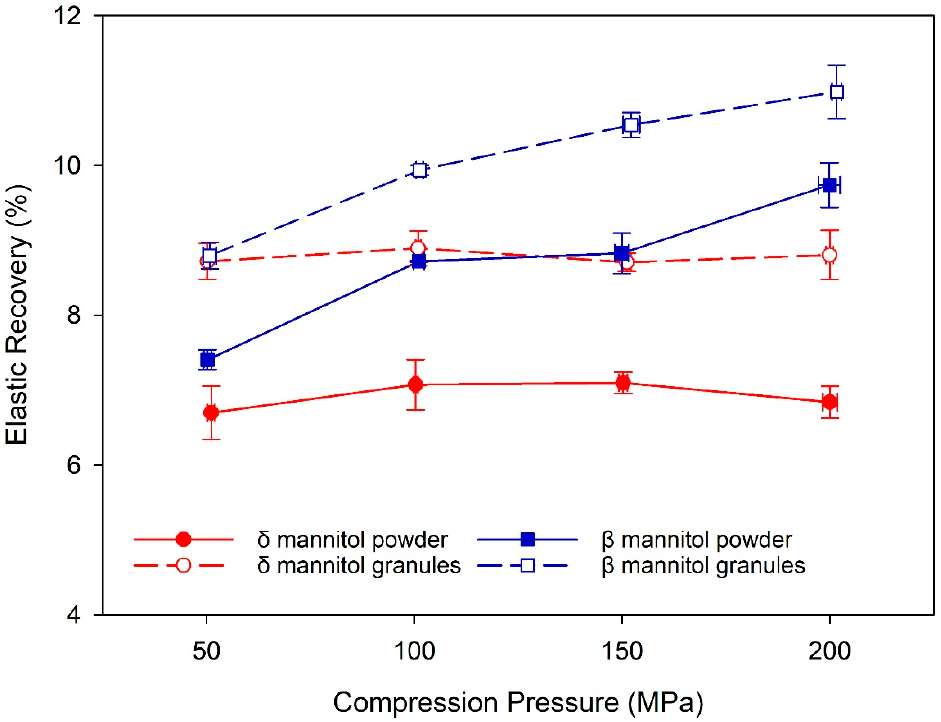
Figure 3. The percentage of elastic recovery for δ and β mannitol powder and their respective granules. Arithmetic means of n = 10 ± S.D.